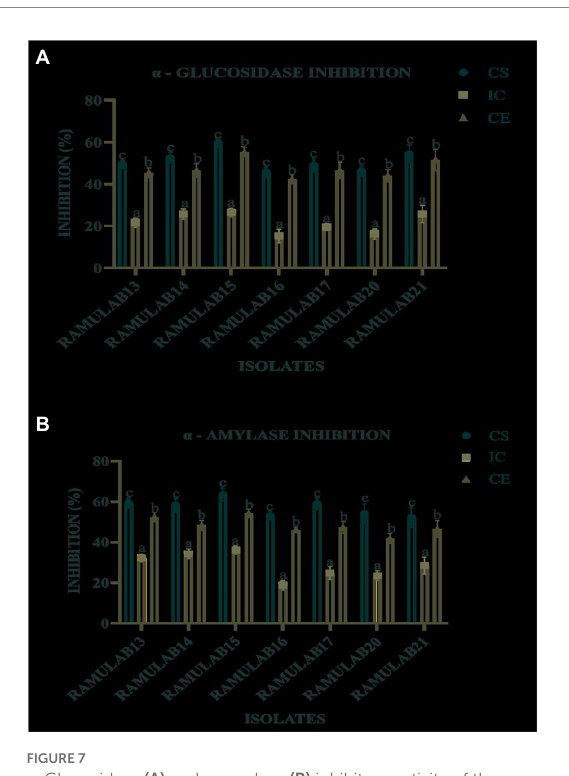
FIGURE 7 α -Glucosidase (A) and α -amylase (B) inhibitory activity of the isolates. Results are presented as mean ± SD. Duncan’s multiple range test shows that the means of the same column that are denoted by different letters (a–d) are substantially different ( p ≤ 0.05).